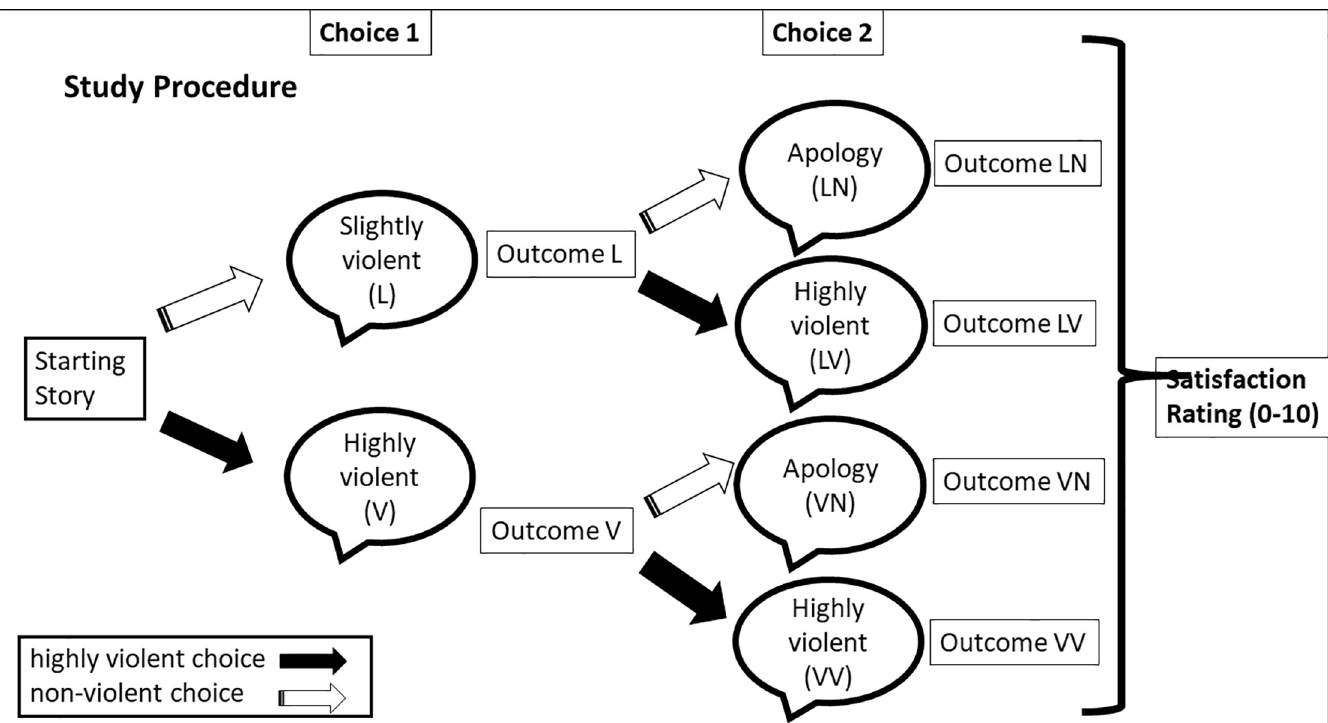
Fig 2. Presented is the order of the tasks for the participants for Study 2, beginning with making choice 1, choice 2 to providing a satisfaction rating.